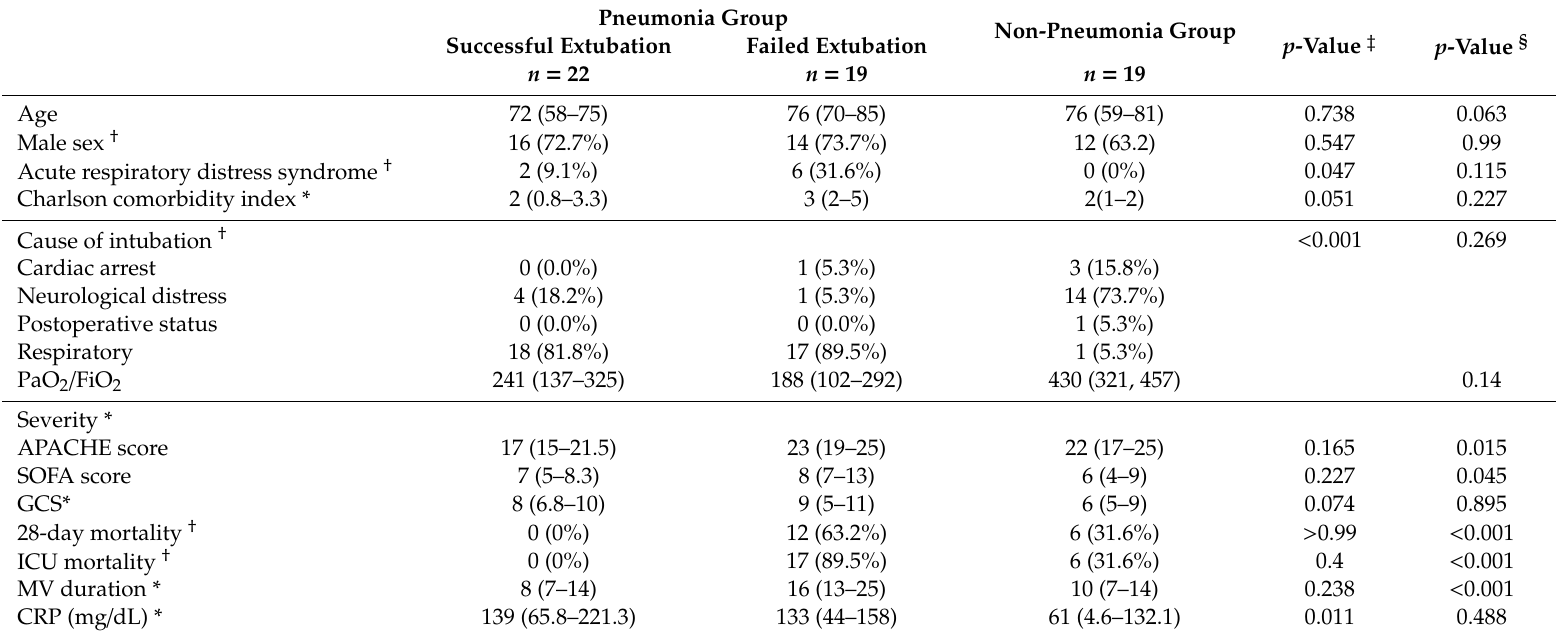
Table 1. Demographics and clinical parameters of mechanically ventilated patients in the